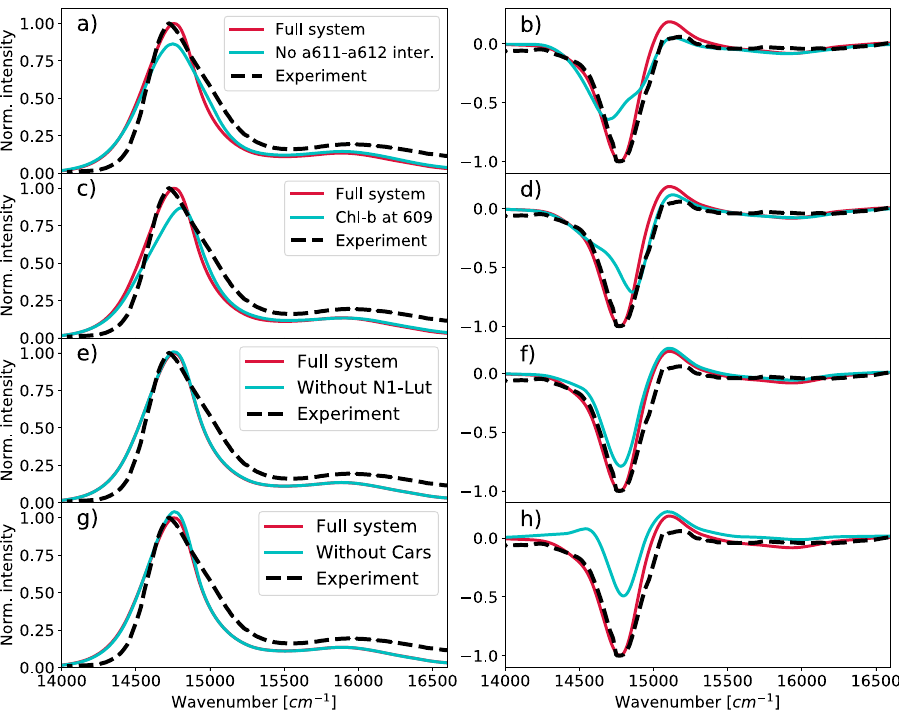
Fig. 7 Effect of individual pigments on the optical spectra of LHCSR1. a Absorption and b CD spectra for the LHCSR1 where the interaction between Chl a611-a612 was set to zero. c Absorption and d CD spectra for the LHCSR1 where the Chl a609 was replaced by the Chl-b. e Absorption and f CD spectra of the LHCSR1 without N1-Lut. g Absorption and h CD spectra of the LHCSR1 without all the carotenoids. The optical spectra were obtained by averaging over spectra of 102 con fi gurations (replicas MD7 and MD8). The experimental spectra (black dashed lines) were taken from ref. 20